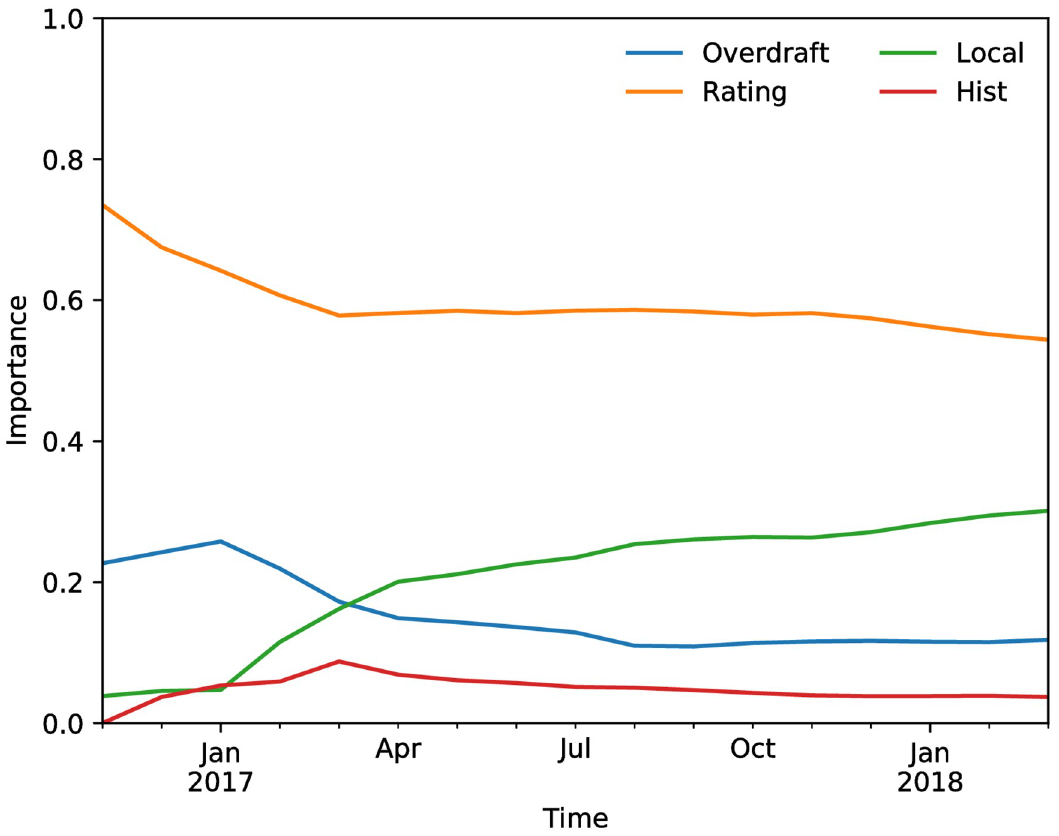
Fig 7. Relative feature importance for the firm features in the random forest